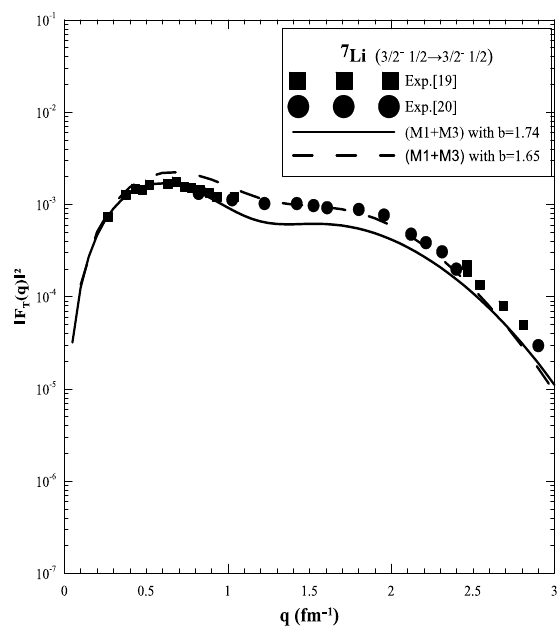
Fig. 1: The transverse form factors for 7 Li ground state calculated in spsdpf model space. The individual multipole contribution of M1 and M3 are shown. The data are taken from Ref. [19] (square) and Ref. [20] (circles).